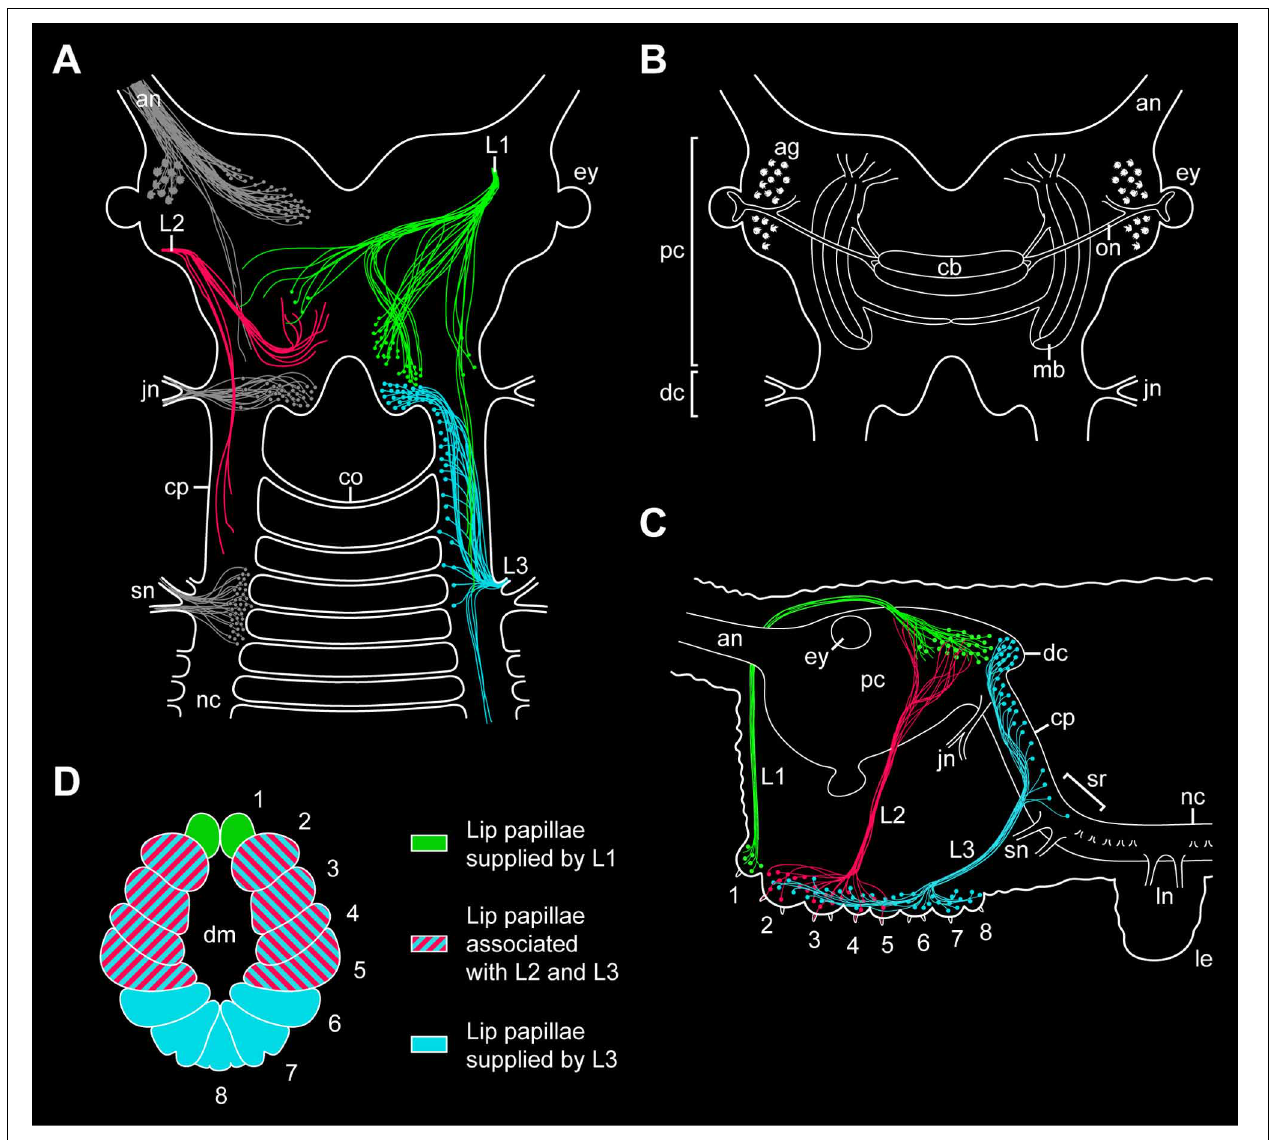
FIGURE 9 | Simplified diagrams summarizing the results of retrograde and anterograde fills of the lip papillae nerves in the onychophoran Euperipatoides rowelli . (A) Position of somata and fibers associated with the three lip papillae nerves, L1, L2, and L3, as revealed by retrograde fills. The innervation pattern of segmental head appendages (antenna, jaw, and slime papilla; see Mayer et al., 2010) is also shown (in gray) to demonstrate their spatial relationship to the lip papillae nerves. (B) Diagram of the onychophoran brain in dorsal view to demonstrate the position of major neural structures and neuropils (combined from various authors, e.g., Schürmann, 1987b; Strausfeld et al., 2006a). (C) Diagram of the onychophoran head in lateral view demonstrating the position of somata and